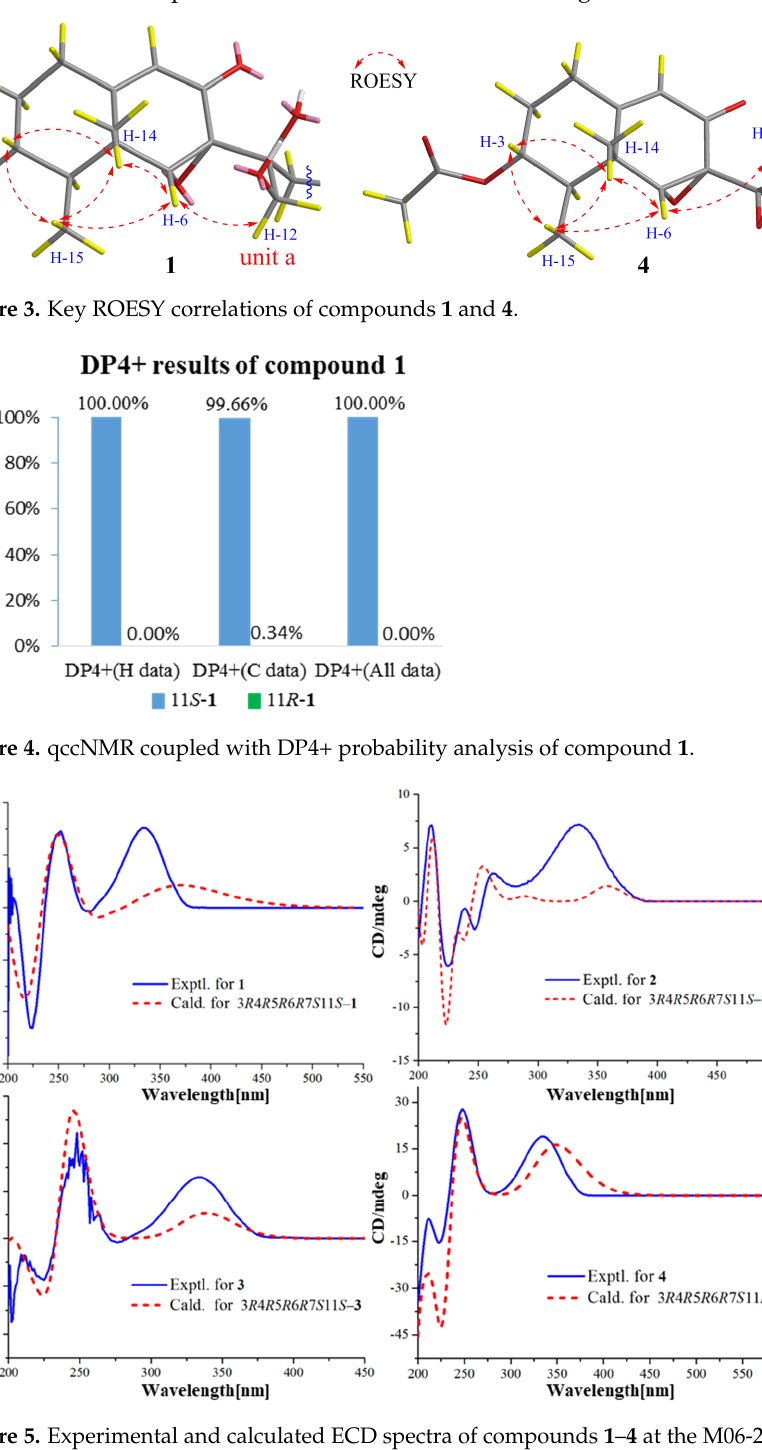
Figure 5. Experimental and calculated ECD spectra of compounds 1 – 4 at the M06-2X/def2-SVP level in methanol.